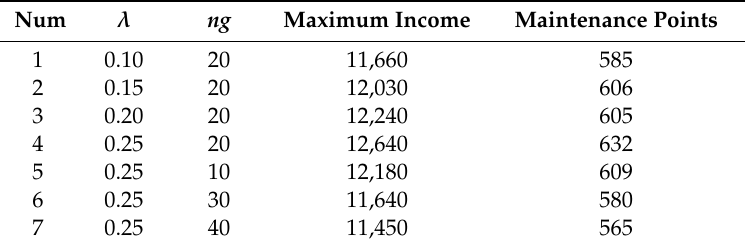
Table 6. The influence of λ and ng on the modified di ff erential evolution algorithm.